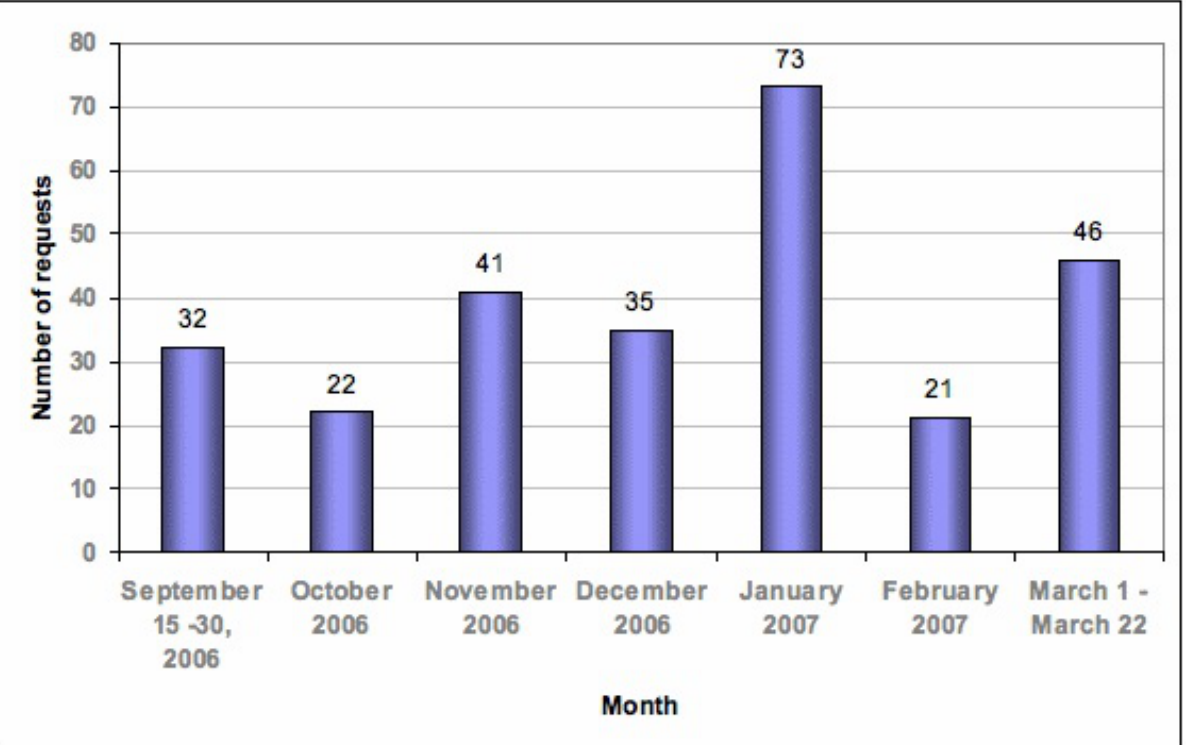
Figure 3. Use of Doctor Chat: number of requests by